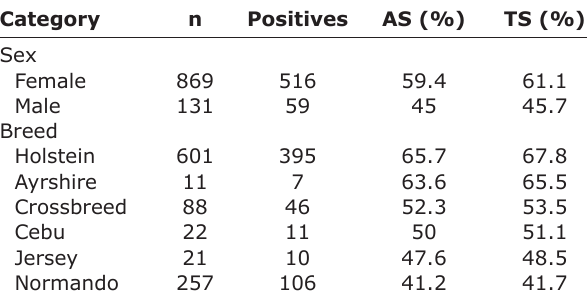
Table-1: AP and PR of IBR by bovine sex and breed in cattle from Sotaquirá, Boyacá. Category